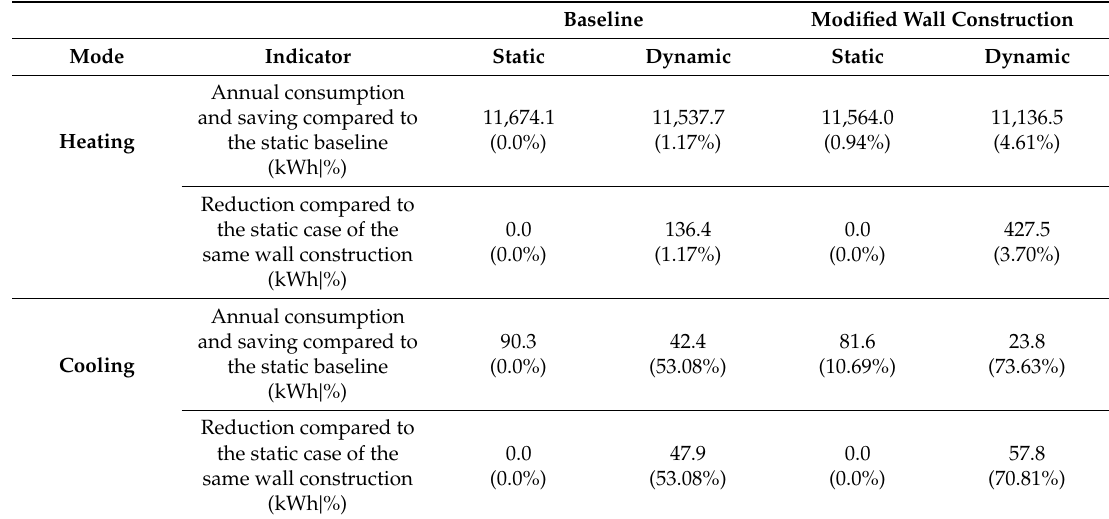
Table 10. Comparison of annual heating and cooling energy consumption for improved thicknesses and densities of the interior and exterior brick layers for the walls of the prototypical Belgian detached house.